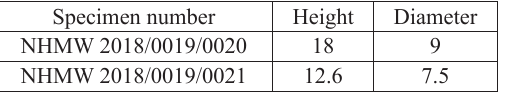
Table 4. Measurements (in mm) of Aplexa cf. subhypnorum Gottschick,